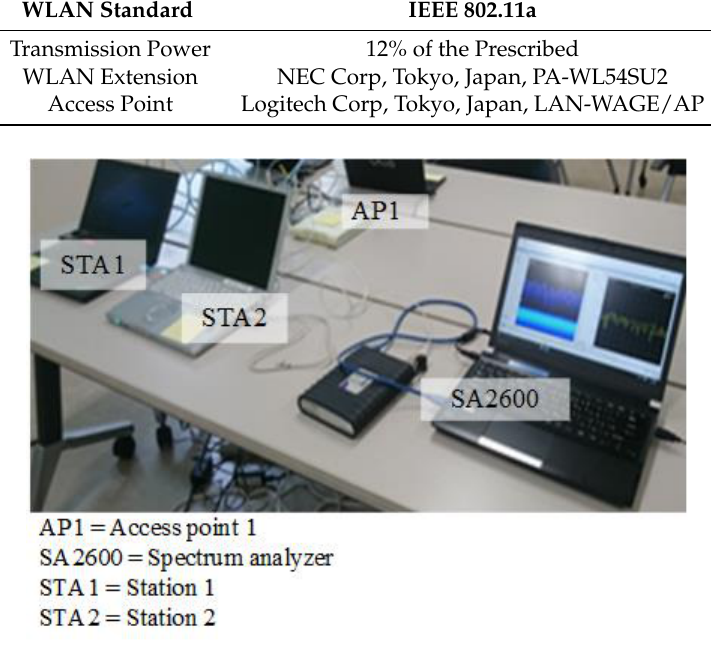
Figure 3. The experimental setup of the WLAN